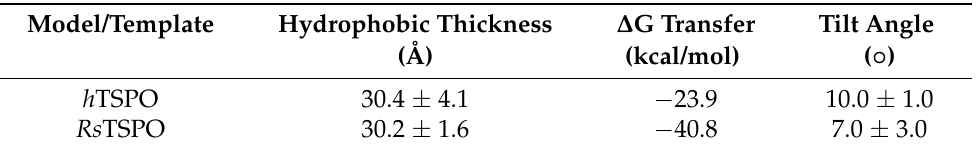
Table 2. Comparison of the hydrophobic thickness and protein tilt angles for the Rs TSPO template and the h TSPO structural model. All values were obtained from the Positioning the Proteins in Membranes (PPM) server